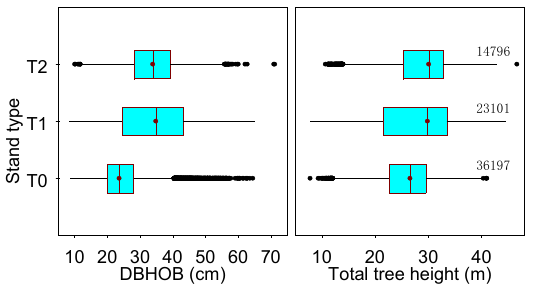
Figure 4. Boxplots of estimated DBHOB and total tree height for the bucked stems contained in the harvester data set for each of the three stand types. The number next to each boxplot on the right indicates the number of stems for the corresponding stand type.